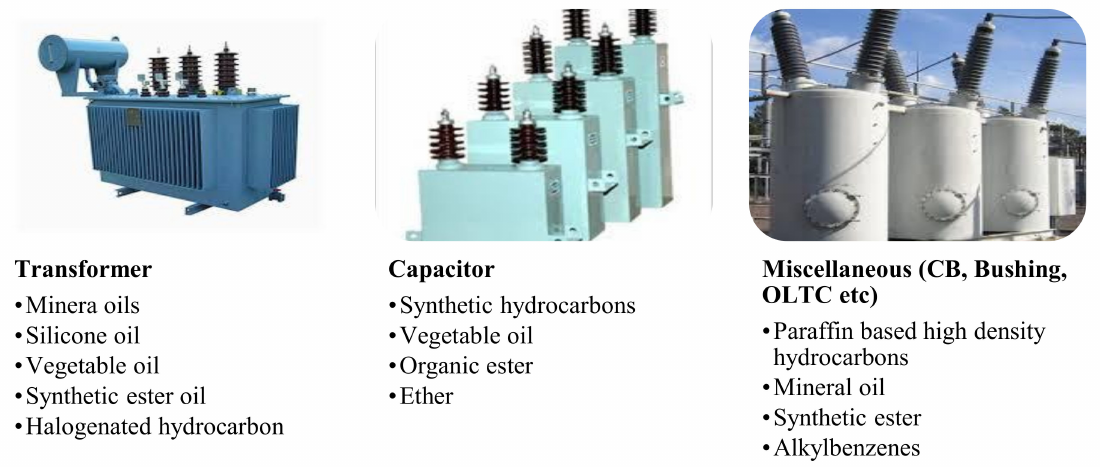
Figure 1. Classification of liquid insulating fluids based on their